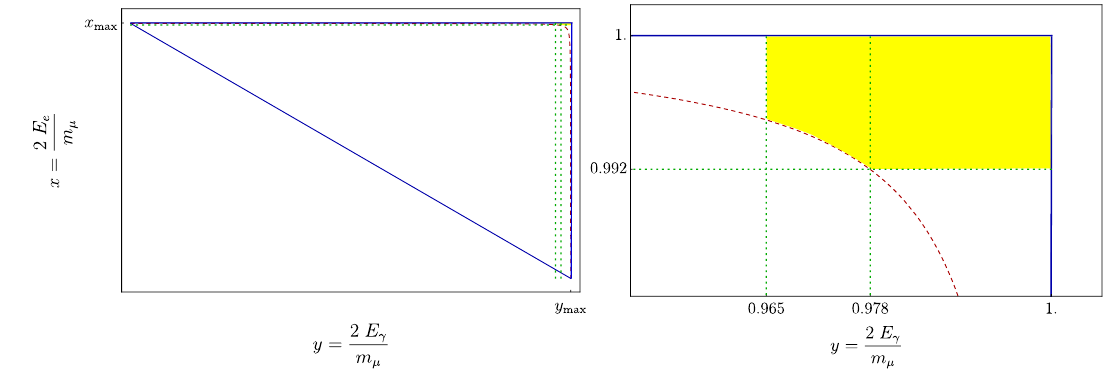
Figure 8 . Realistic version of the phase space region limited by the experimental cuts of the MEG experiment, given in eq. (5.6). The figure on the right shows a zoom of the figure on the left, centered on the colored